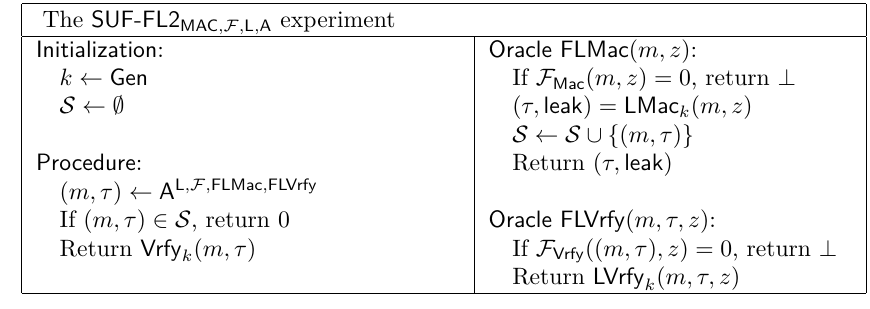
Table 4: The SUF - FL2 experiment. In stuck-at (resp., differential) attacks, F Mac and F Vrfy represent the stuck-at (resp., differential) faulty matrices functions and predicates. In the ℓ -bounded case, the predicates F and F return 0 if the fault injection tuple z Mac Vrfy contains more than ℓ components ̸ = “ · ”. We denote it by SUF - FL1 when there is only fault injection in either Mac or Vrfy